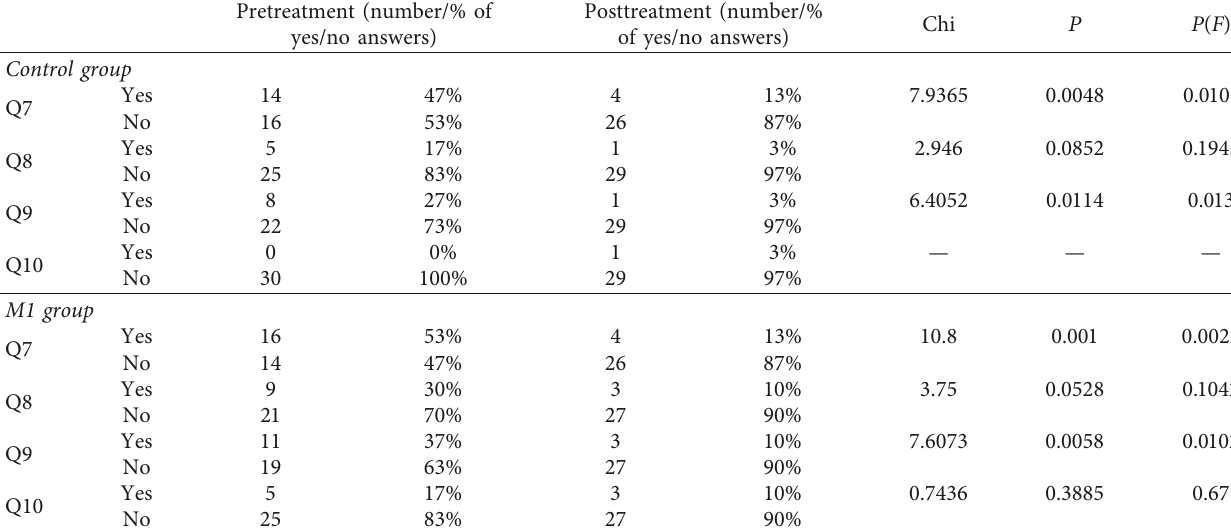
Figure 5: Box plots of responses of each VAS question in posttreatment test for all groups. Source: own. (a) Question 1. (b) Question 2. (c) Question 3. (d) Question 4. (e) Question 5. Table 4: p values of the frequency ( P ), chi-square test values (Chi), and Fisher’s exact test ( P ( F )) results for the control group, M1 group, and M2 group. Values are significant at α 0.05 (cid:30)